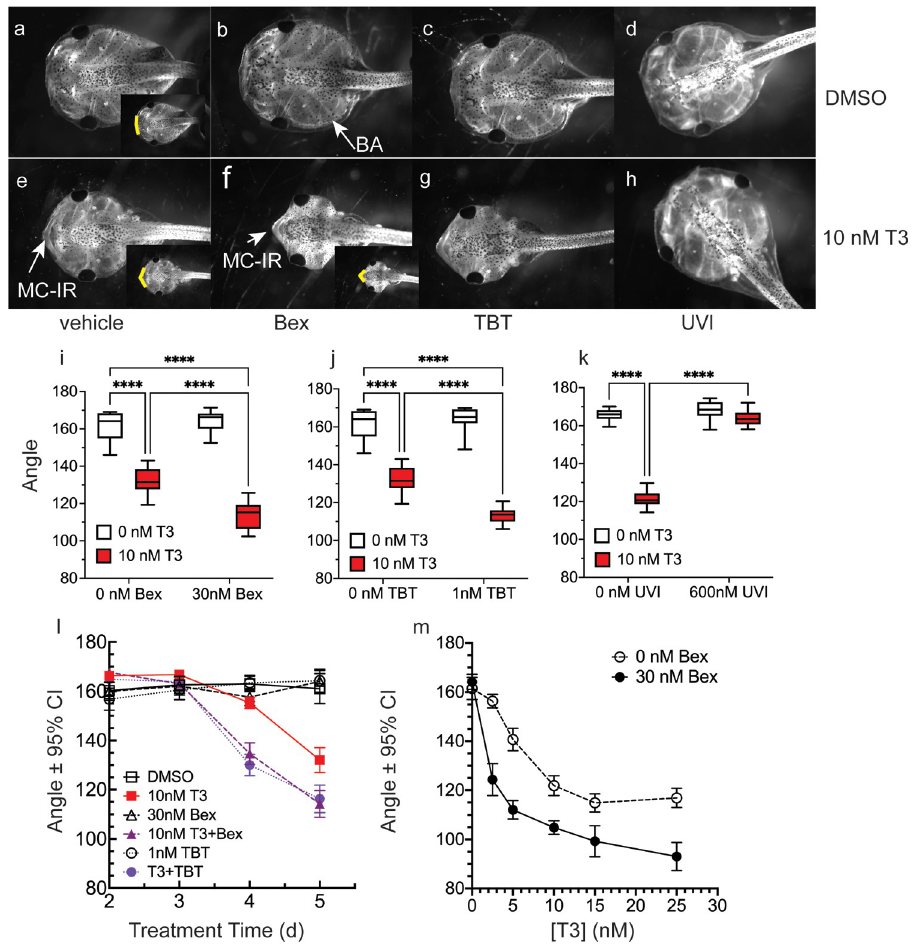
Fig 1. RXR agonists potentiate T3-induced changes to lower jaw morphology, while an RXR antagonist abrogates T3 action. a-h: Representative dorsal head photos of tadpoles treated for five days starting at 1wk-PF (as indicated: